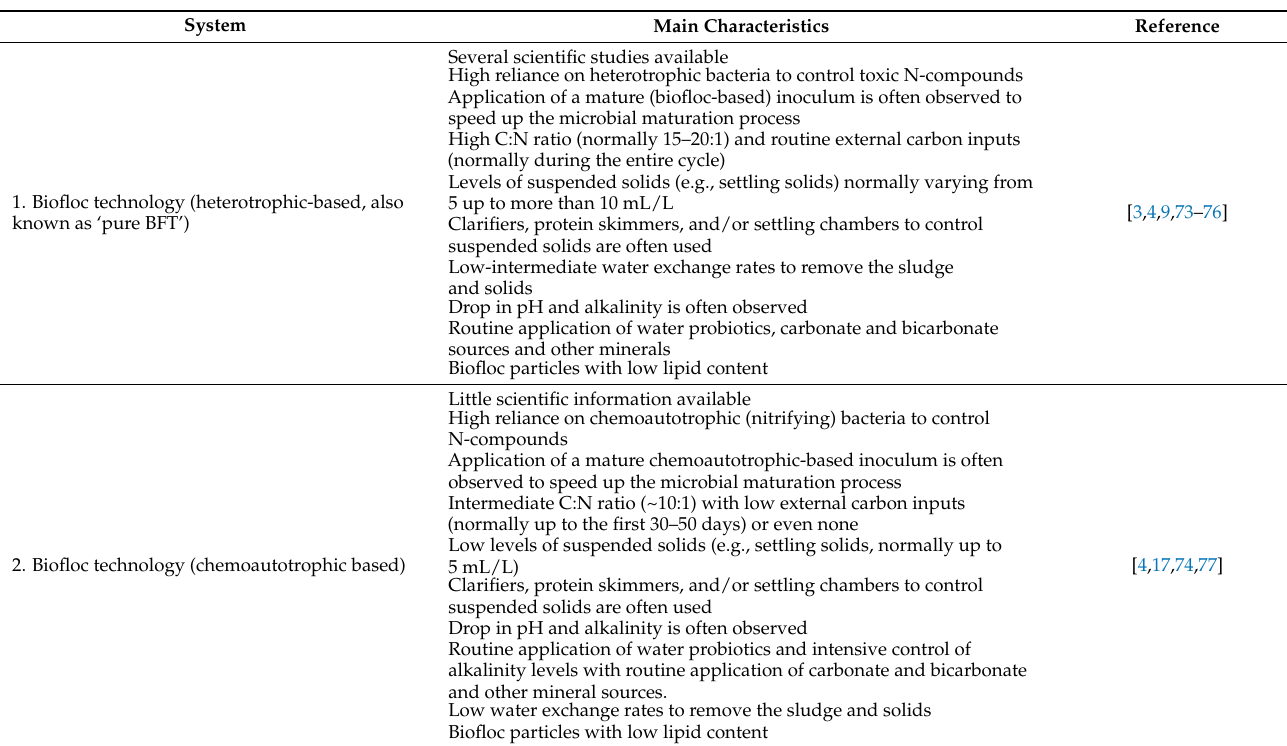
Figure 3. Examples of commercial microbial-based systems: ( upper left ) super-intensive indoor operations using chemoautotrophic-based BFT in Vietnam; ( upper right ) semi-biofloc (heterotrophic-based) in Thailand; ( lower left ) bioreactor being used in rice bran-based synbiotics in Vietnam; and ( lower right ) Aquamimicry integrated with tilapia in Thailand. Table 1. Summary of biofloc technology and similar microbial-based approaches used in fully lined ponds or tanks, showing the main characteristics of the systems and references. The information presented below is a general guide only. Specific characteristics may change according to different culture conditions and management